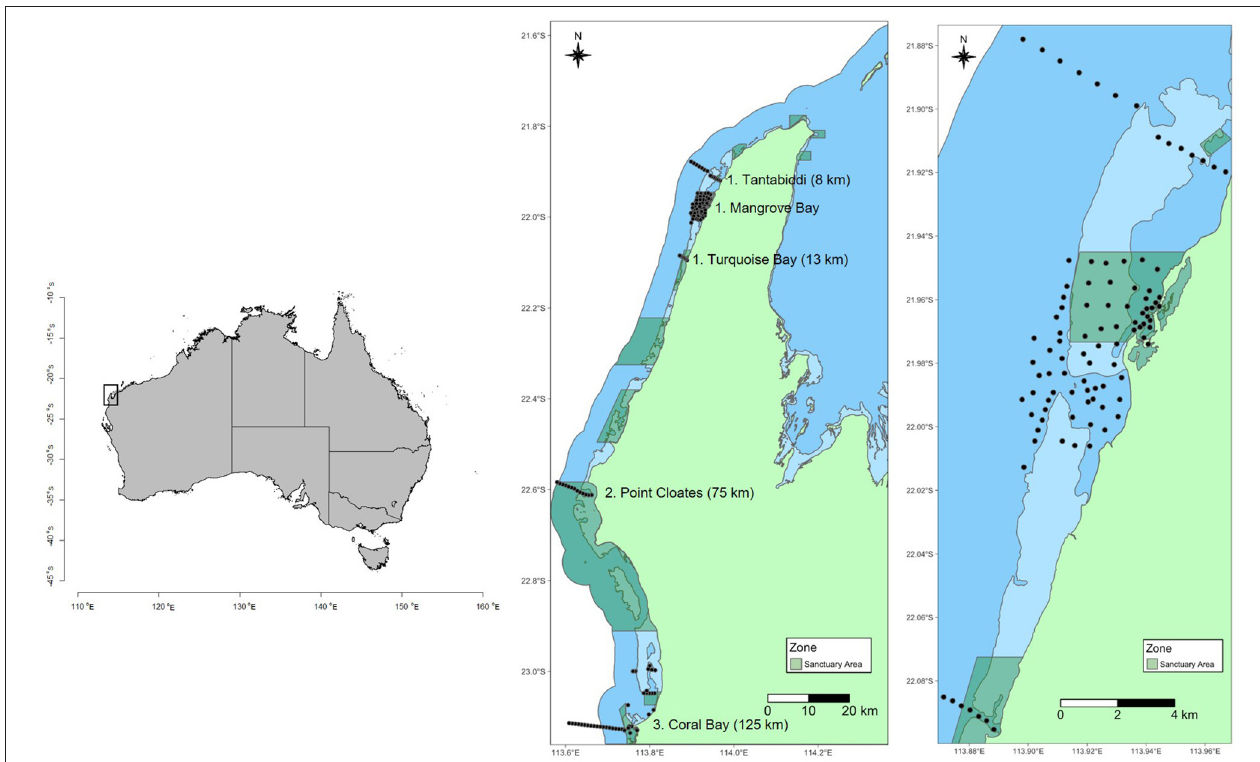
FIGURE 1 | Map showing location of groups of receivers along the Ningaloo Reef. Dark blue shading is Ningaloo Marine Park boundary. Light blue shading shows intertidal areas ( < 2m at Lowest Astronomical Tide –LAT). Green shading shows sanctuary zones (no fishing or other extractive activities allowed). Black circles show location of acoustic receivers from Tantabiddi to Coral Bay. Number in brackets next to site names is the distance in kilometers from the center of the Mangrove Bay array and the center of the site